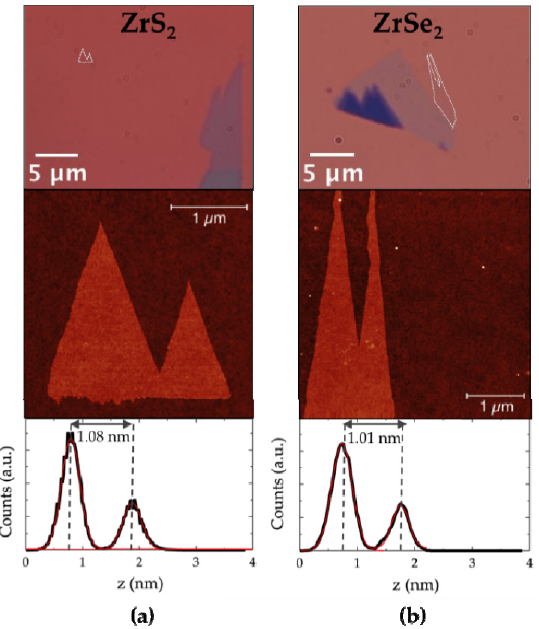
Figure 2. Optical image ( top panel ), atomic force microscopy measurement ( middle panel ) with the corresponding height histogram ( bottom panel ) for a monolayer of ( a ) ZrS 2 and ( b ) ZrSe 2 . For clarity, the contour of the flake has been marked with a white line in the optical image.